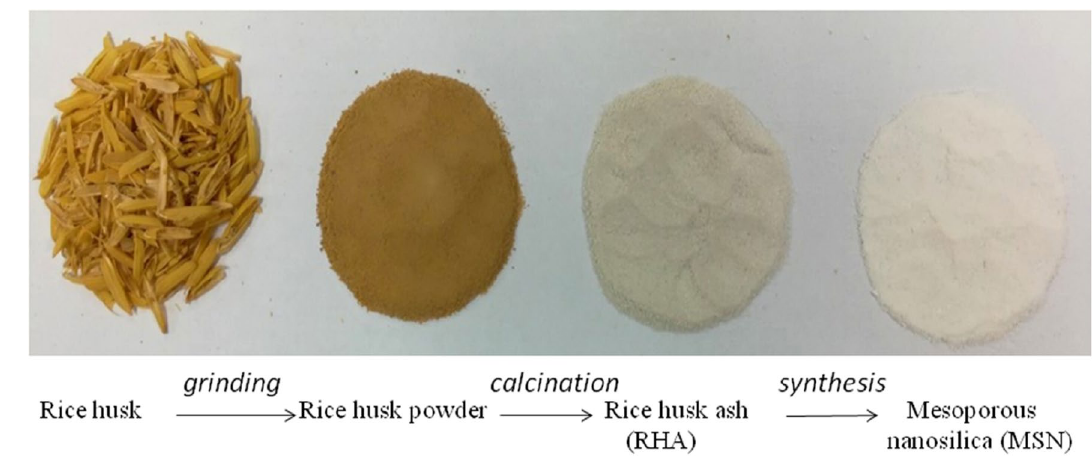
Figure 2. Physical appearance of the different stages of mesoporous nanosilica synthesis.